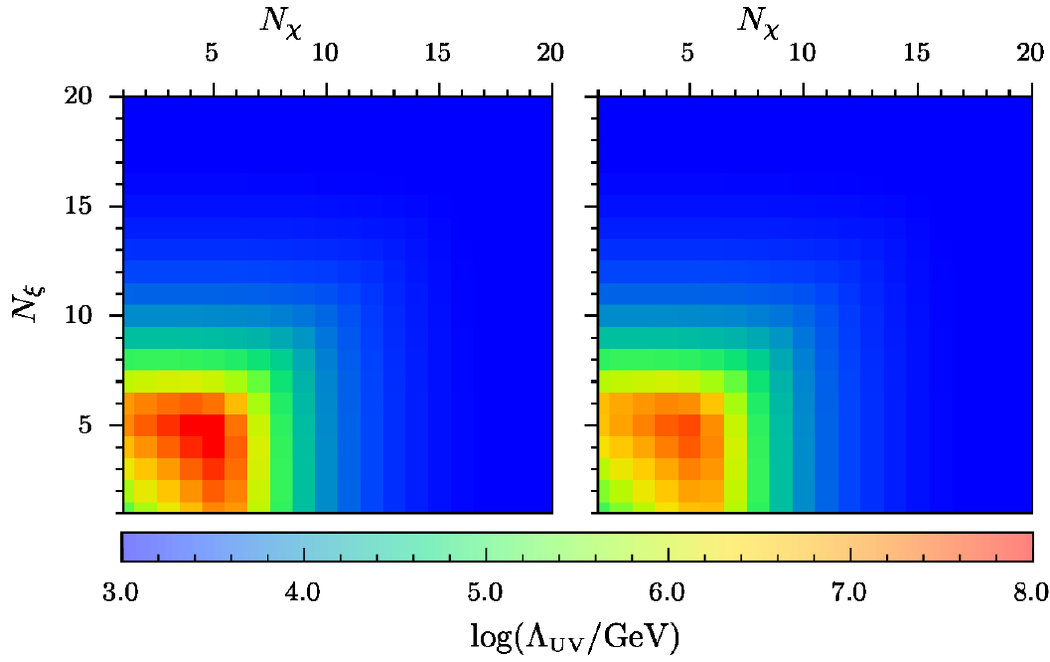
Figure 6 . Largest possible UV scale in the set-up described in (cid:12)gure 5. The results were obtained using Left : RGEs including scalar and SM gauge contributions. Right : full